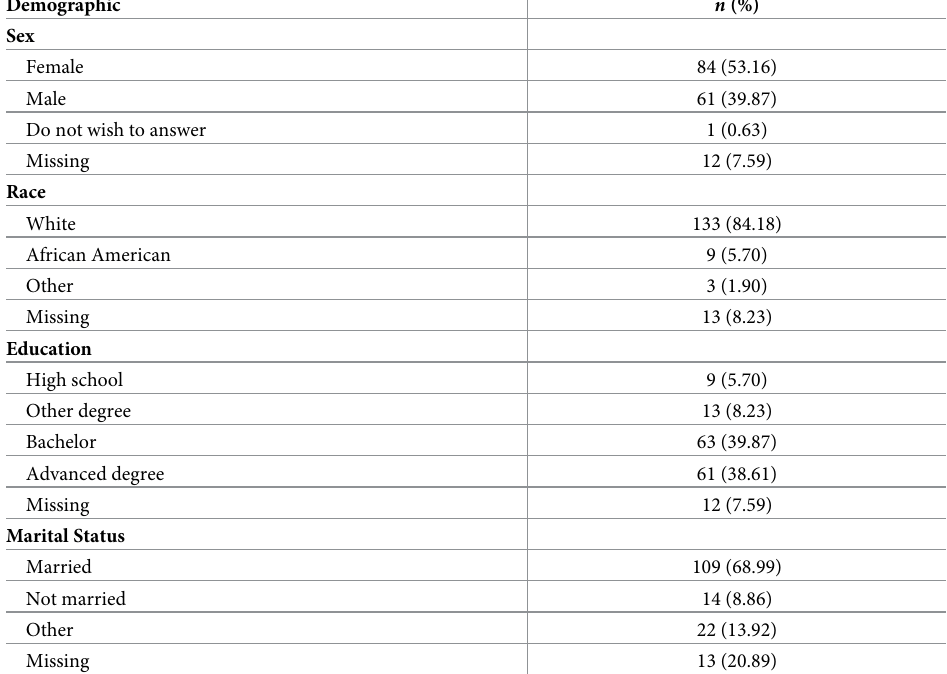
Table 1. Demographic characteristics of patients with